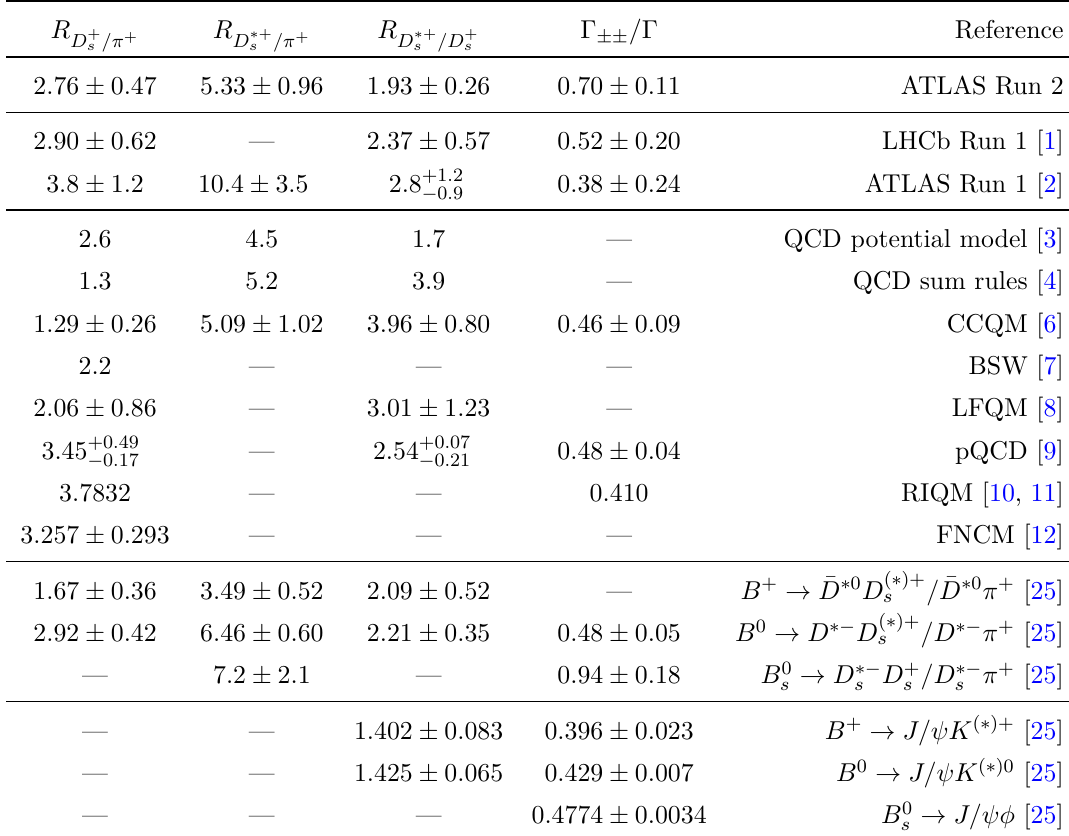
Table 5 . Comparison of the measured quantities with the results of earlier measurements and theory predictions. Values of the corresponding ratios of branching fractions calculated using eqs. (7.1)–(7.3) and eq. (7.4) and of transverse polarization fractions for B + , B 0 , and B 0 are also shown. No phase-space corrections are applied to the ratios and the quoted uncertainties are the ones propagated from the world average uncertainties of the individual decay branching fractions. For all experimental measurements, quadrature sums of all uncertainties are